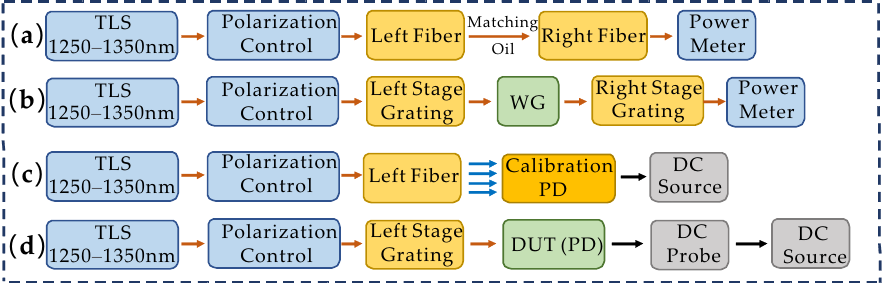
Figure 6. Experimental setup for the responsivity measurements. ( a ) Loss of system link. ( b ) Loss measurement of a single grating coupler. ( c ) Calculation of the optical power that reaches the surface of the grating coupler. ( d ) The optical current measurement of the